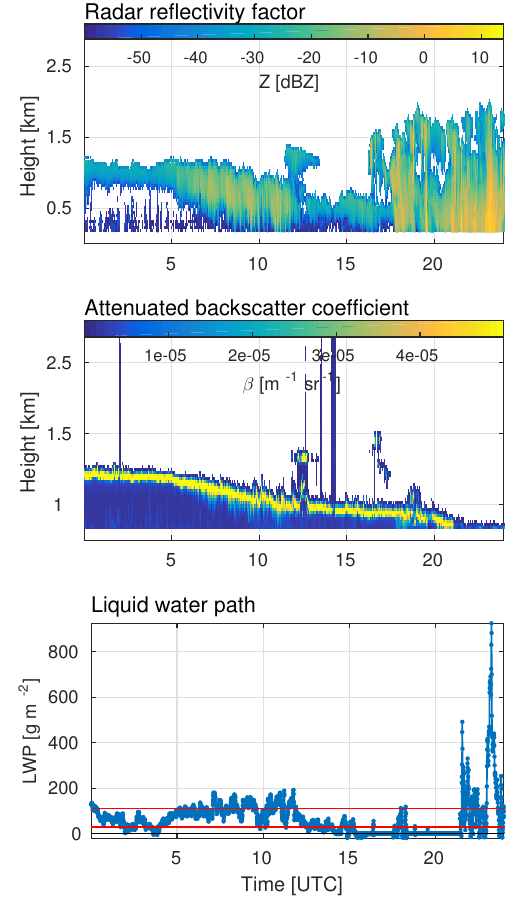
Figure 1. The time–height cross section of the radar reflectivity fac- tor from WACR, the attenuated backscatter coefficient from Vaisala CT25K and the liquid water path from the MWR for a full day of measurements on 3 November